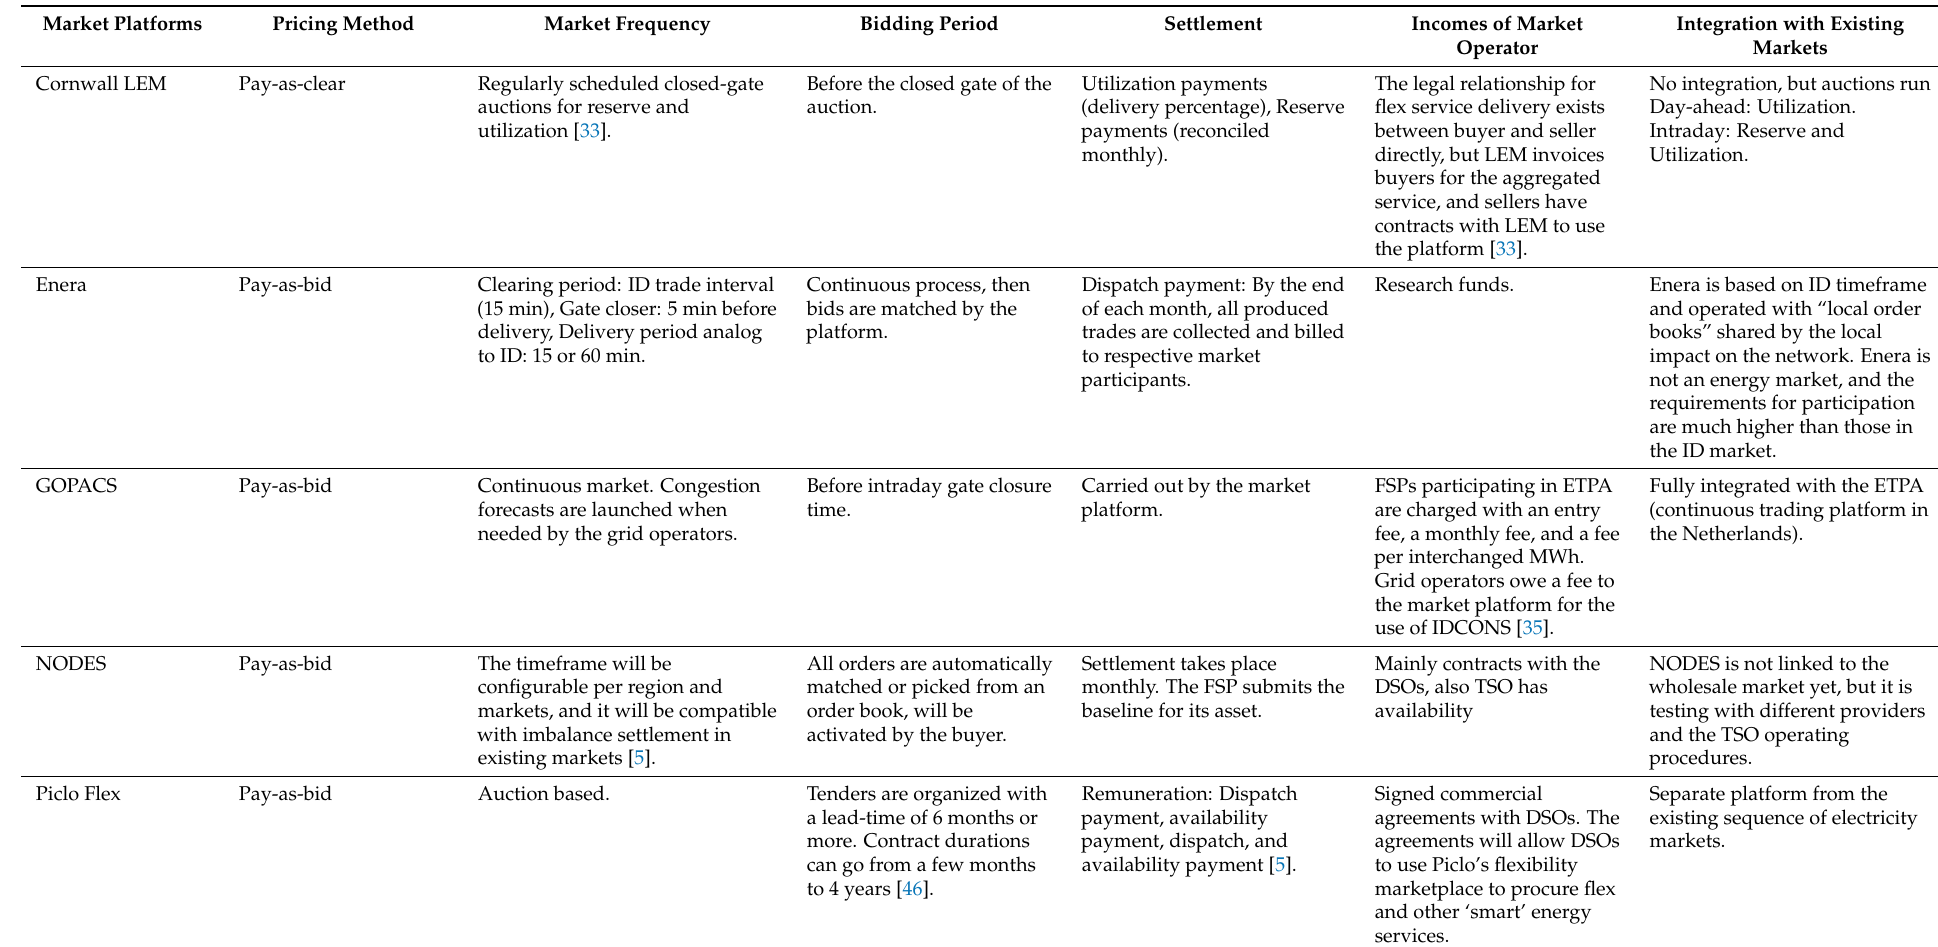
Table 4. Market timing of the market